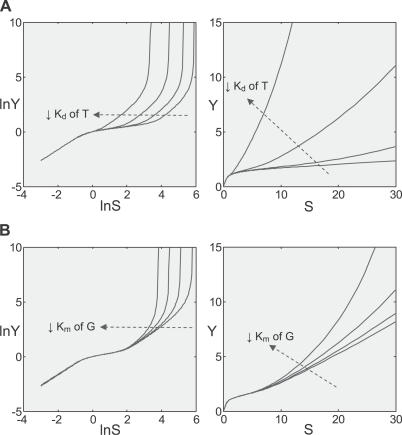
Variation of Saturation Terms Affects the Length of Superlinear Controlled and Linear Uncontrolled Phases(A) Lowering the dissociation constant Kd for transcription factor T binding to the gene promoter shortens the superlinear highly controlled phase.(B) Lowering the Michaelis–Menten constant Km of enzyme G for clearance of Y shortens the linear uncontrolled phase.